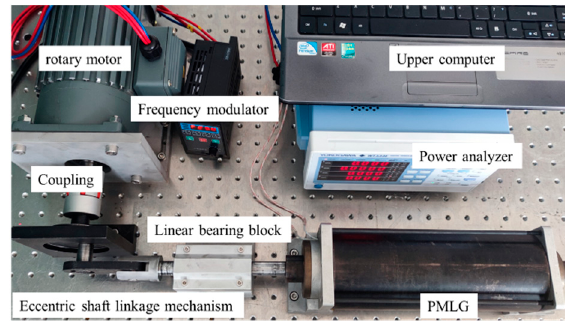
Figure 10. Prototype test system diagram.